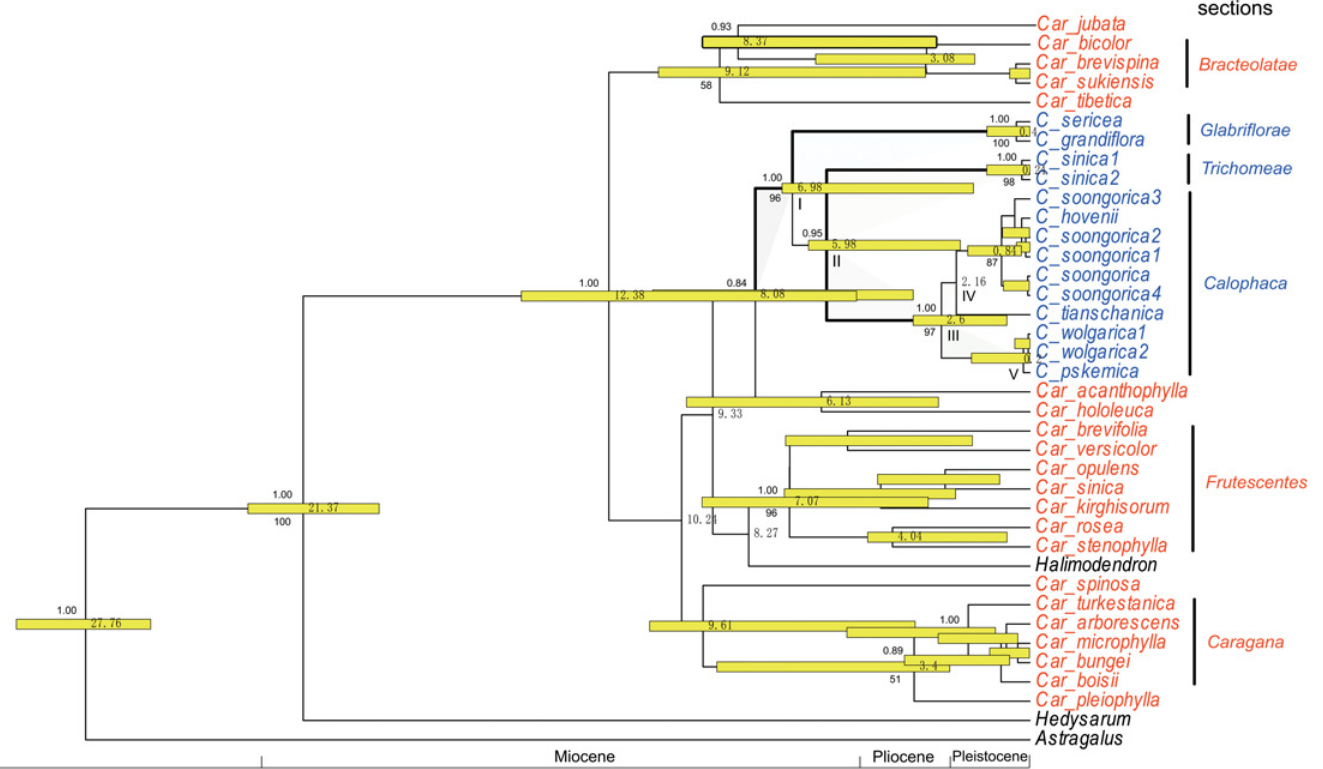
Fig 2. Chronogram of Calophaca and outgroups Caragana , Halimodendron , Hedysarum , and Astragalus , with maximum clade credibility performed by BEAST. Dates of divergence are shown to the right of nodes, and posterior probability values are shown to the left of